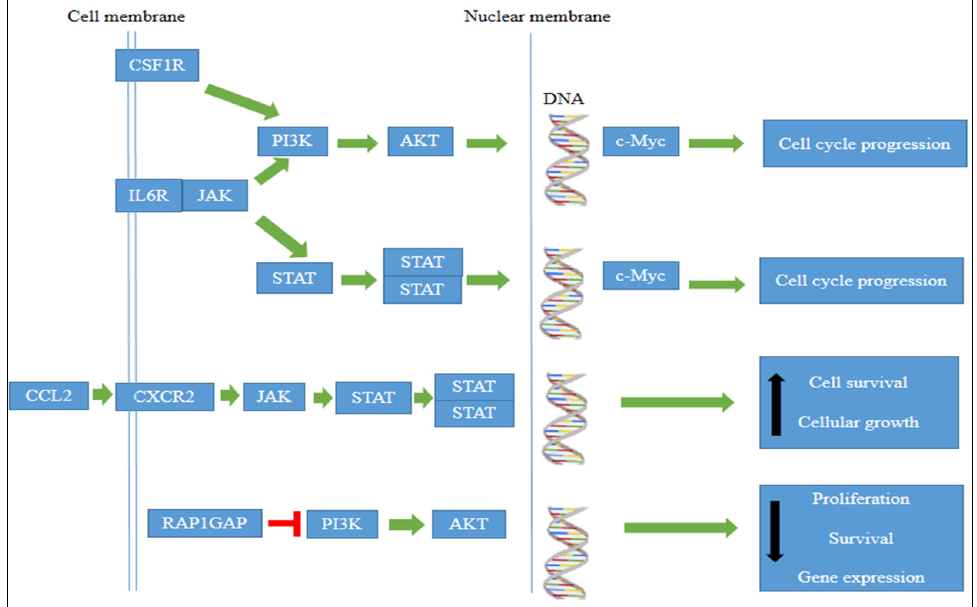
Figure 11. Image showing how significantly expressed genes affect JAK/STAT, PI3K/AKT, and c-Myc activation. Adapted from DAVIVD software.